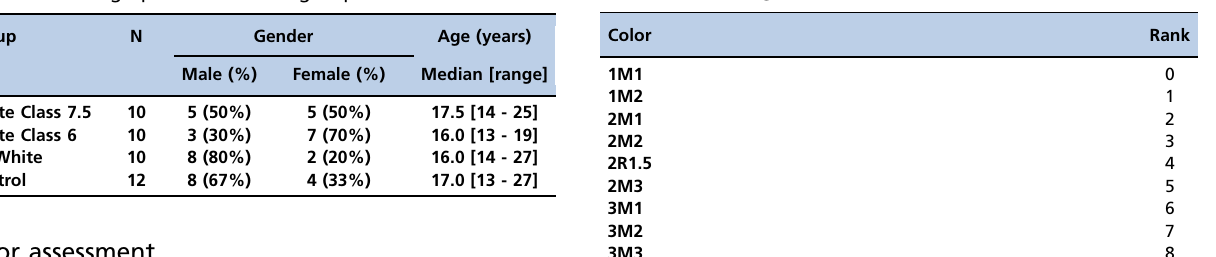
Table 2 - Ranking on the Vita 3D-Master color scale.